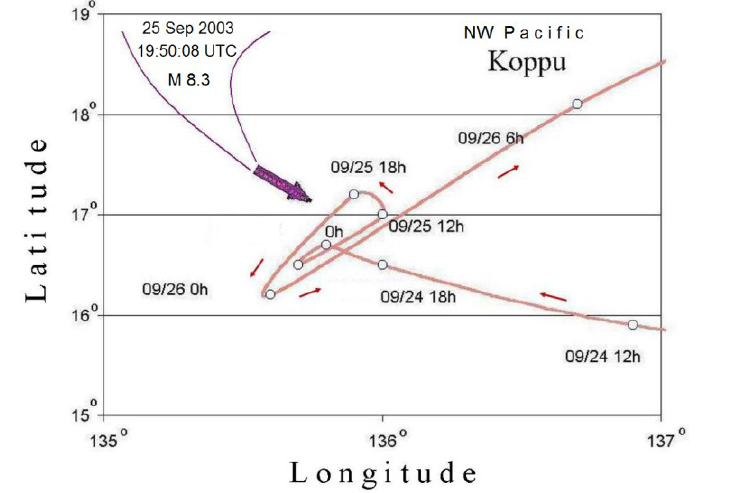
Fig. 7. Typhoon KOPPU in NW Pacific Ocean makes loops 20 hours before Hokkaido Mw 8.3 earthquake on 25 September 2003 [19].